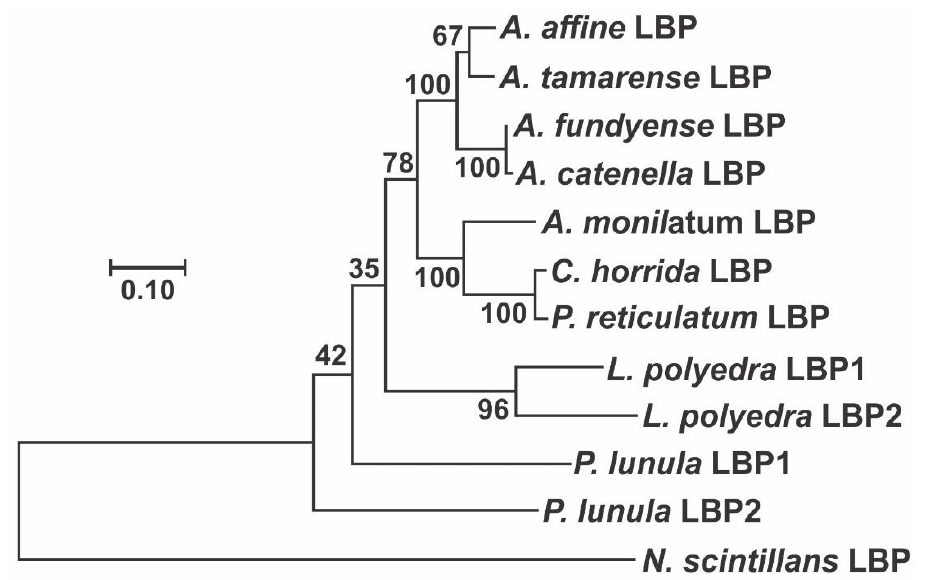
Figure 7. Molecular Phylogenetic analysis by a Bayesian method, showing the evolutionary pattern of LBP from the species of the genera Alexandrium , Lingulodinium , Pyrocystis and Protoceratium that have their protein published in GenBank, using the sequence from N. scintillans as outgroup. The percentage of trees in which the associated taxa clustered together is shown next to the branches. There was a total of 435 positions in the final dataset and the tree is drawn to scale, with branch lengths measured in the number of substitutions per site.